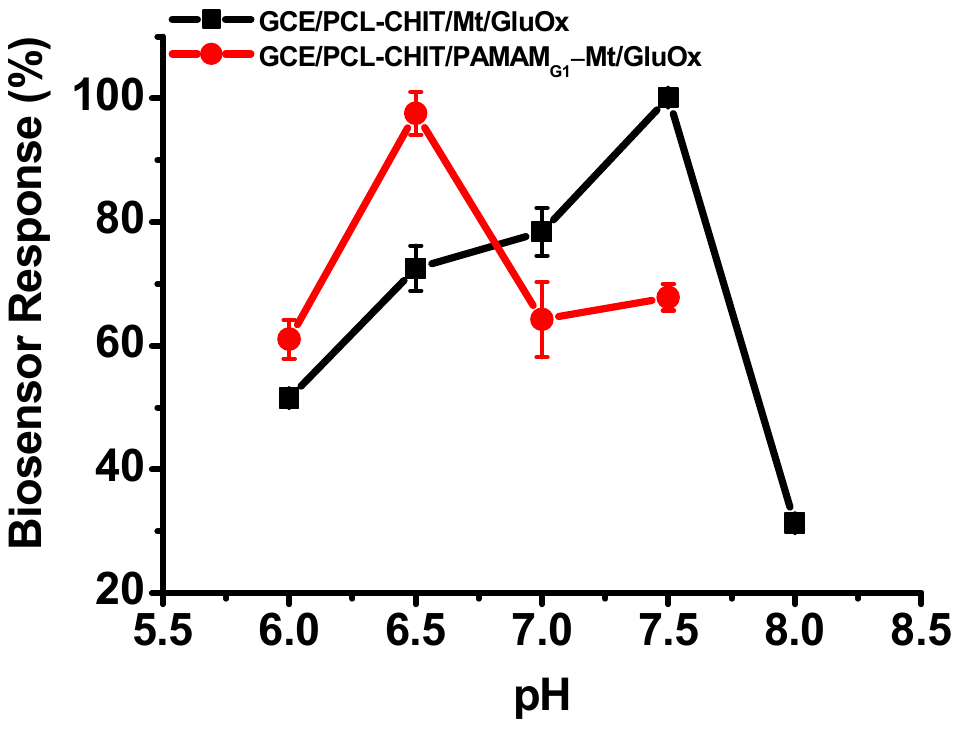
Figure 6. Optimum pH for the GCE/PCL–CHIT/Mt/GluO x and GCE/PCL–CHIT/PAMAM G1 – Mt/GluO x biosensors (in 50 mM sodium phosphate buffer while stirring at room temperature; at − 0.7 V; error bars show the standard deviations of three measurements).